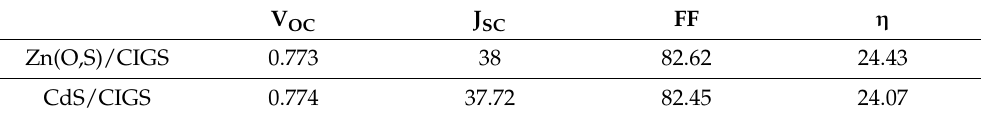
Figure 8. J–V characteristics of the new structure Zn(O,S)/graded-CIGS/Si. Table 4. Performance parameters of the both structures: CdS/graded-CIGS and Zn(O 0.82 S 0.18